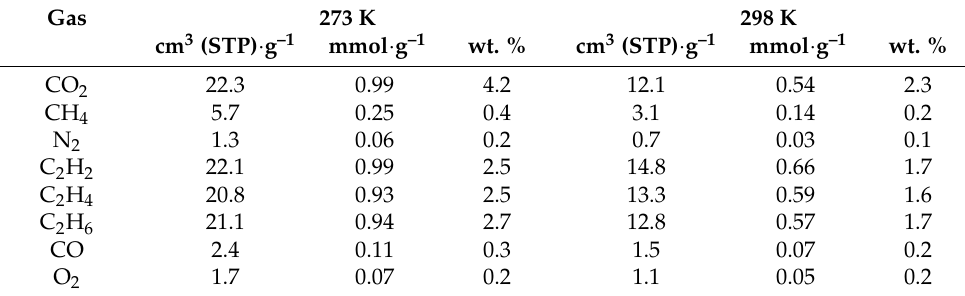
Table 1. Gas uptakes in 1a at 273 K and 298 K.